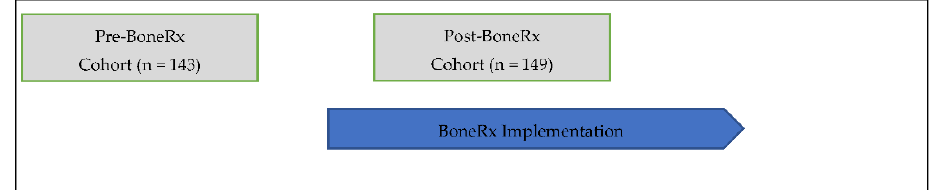
Figure 2. Study design.